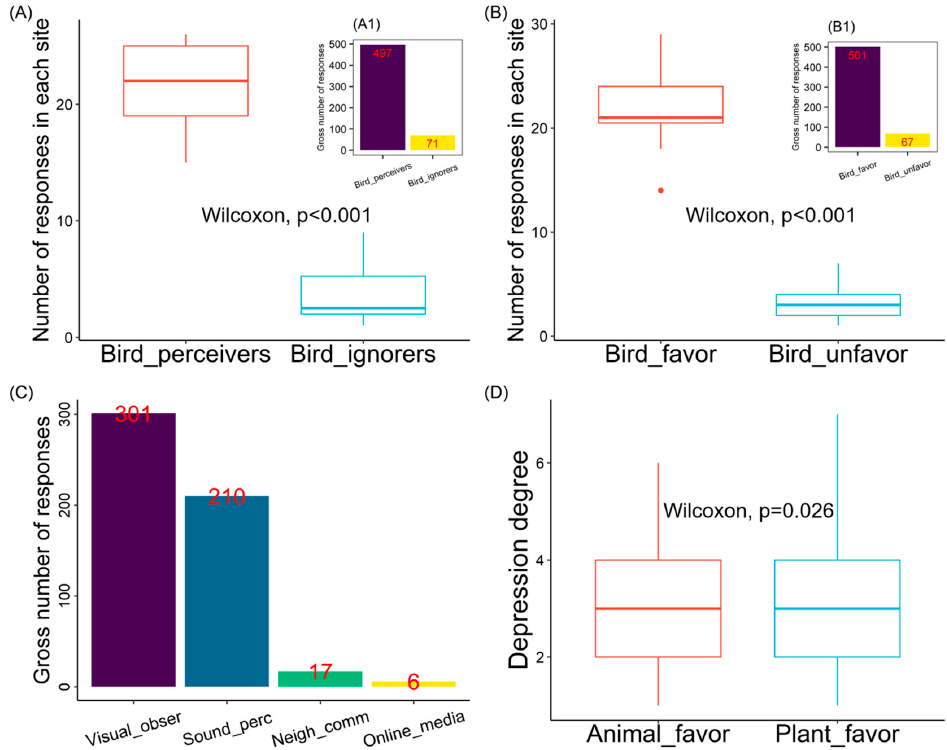
Figure 2. Characteristics of cultural ecosystem services provided by biodiversity within urban Beijing’s residential communities. Panels: comparisons between ( A ) the number of respondents who perceived or ignored birds in their living spaces, and subfigure ( A1 ) showed the gross number of respondents of the two population guilds, ( B ) the number of respondents who like or dislike birds in the neighborhood, and subfigure ( B1 ) showed the gross number of respondents holding each attitude, ( C ) the major way to enjoy neighborhood birds in all the sampled residential communities, and ( D ) the depression degree of respondents who favor animals or plants that appeared in their living spaces.